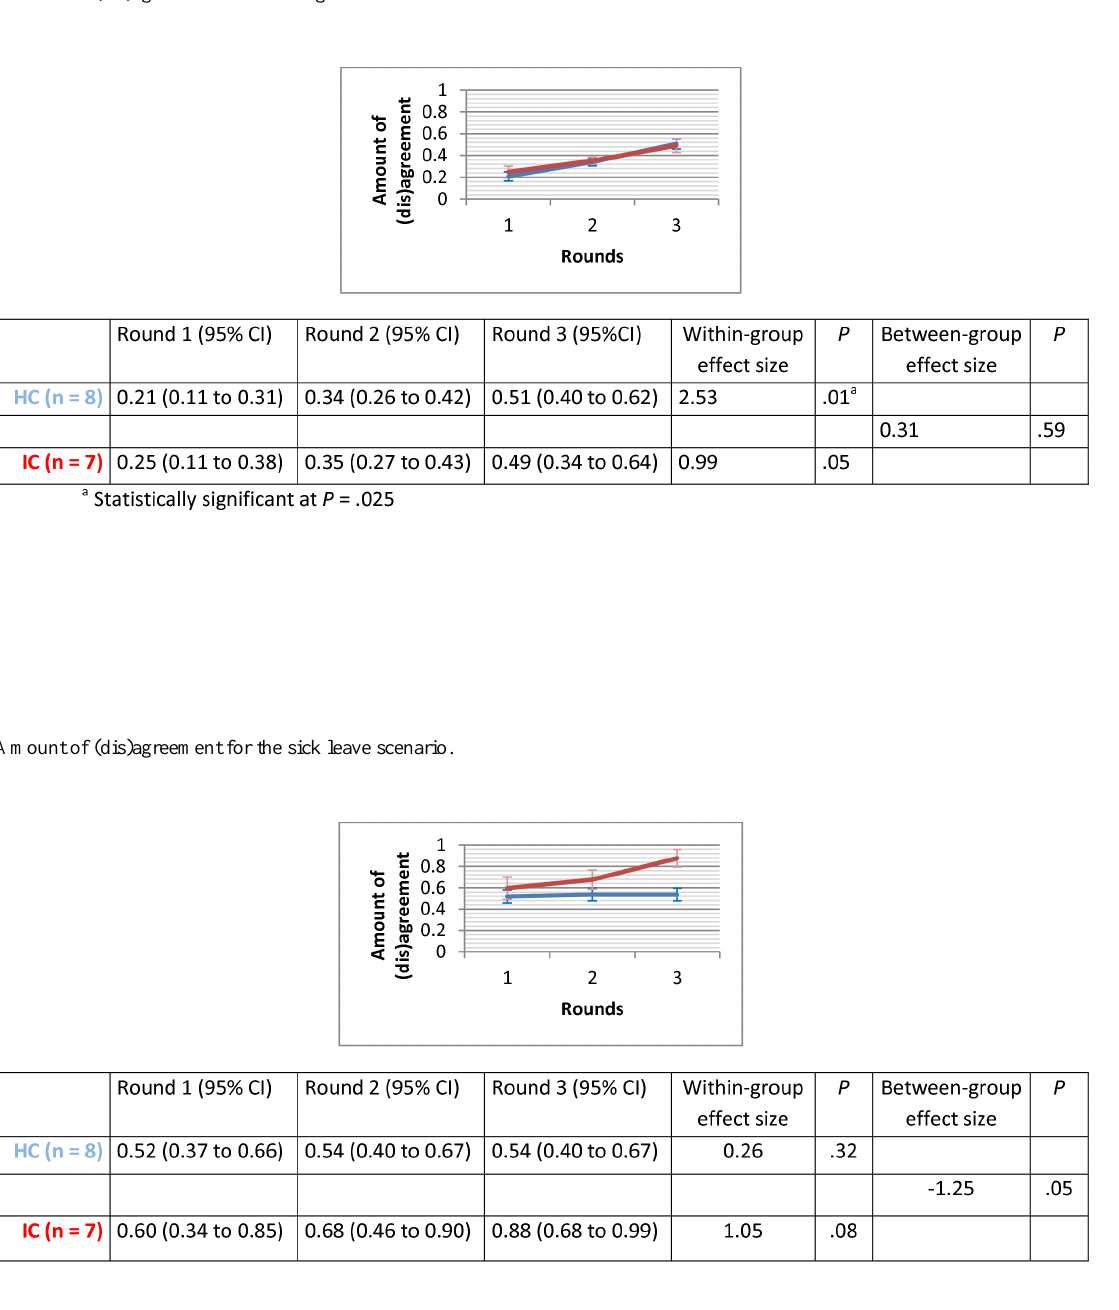
Figure 7. Amount of (dis)agreement for the drug use scenario.